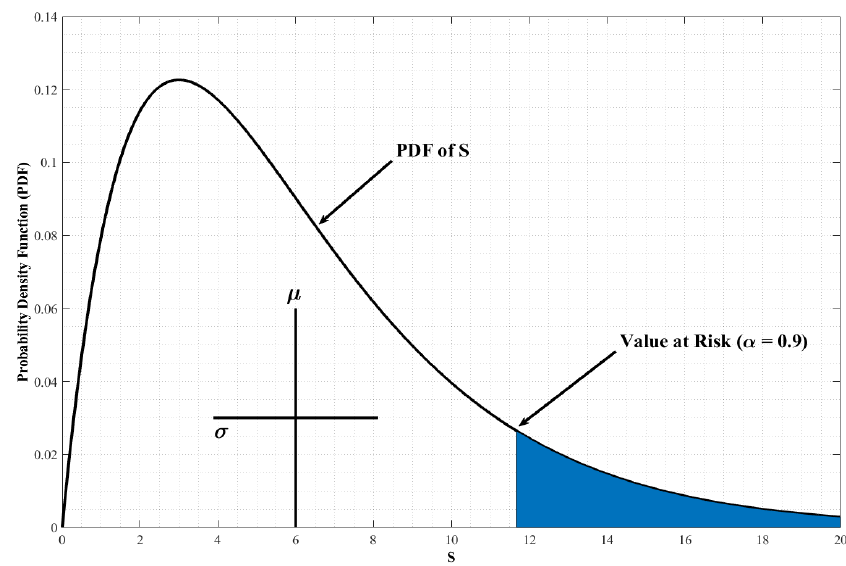
Figure 6. Graphical illustration of the mean-variance ( µ , σ ) and VaR risk measures ; see Definitions 7 and